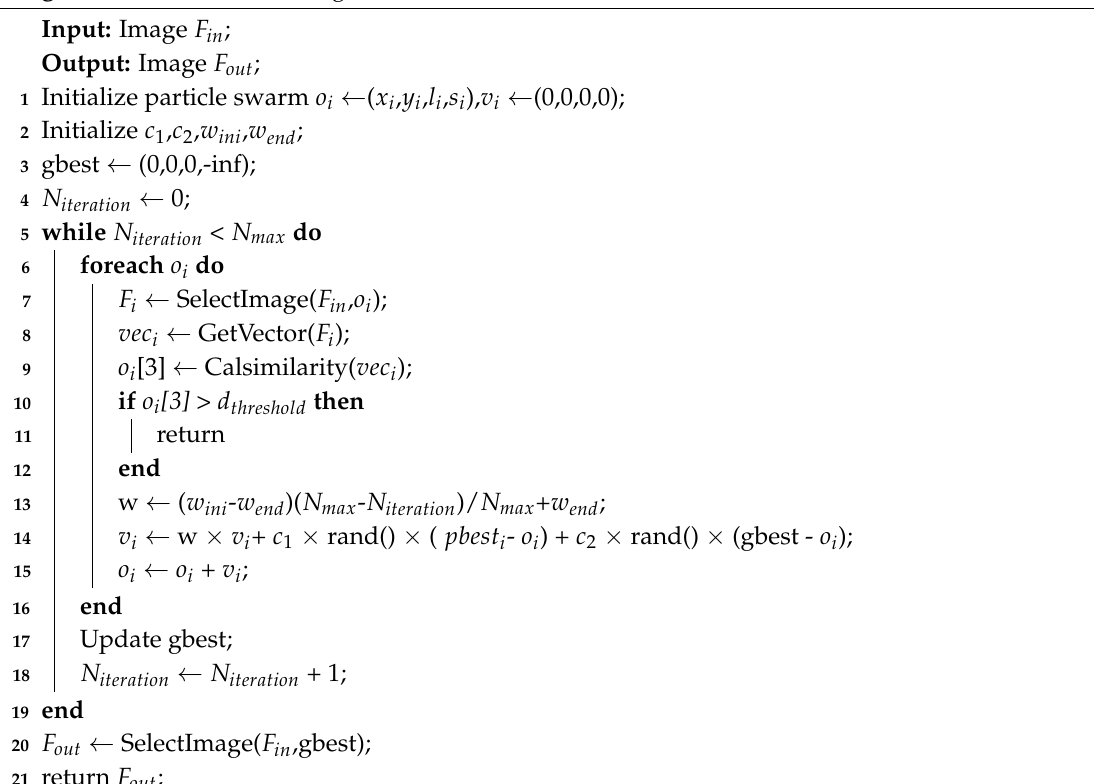
Algorithm 1: PSO-based image-block